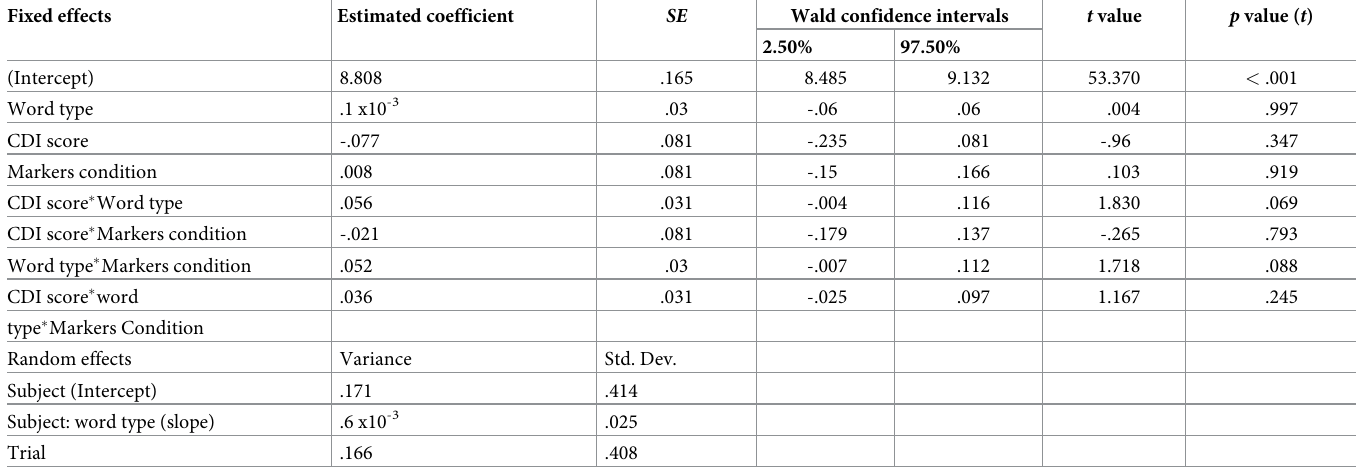
Table 7. Summary of the linear mixed-effects model of (log transformed) looking times on the segmentation trials for participants in experiment 2 (with median split for vocabulary size). Fixed